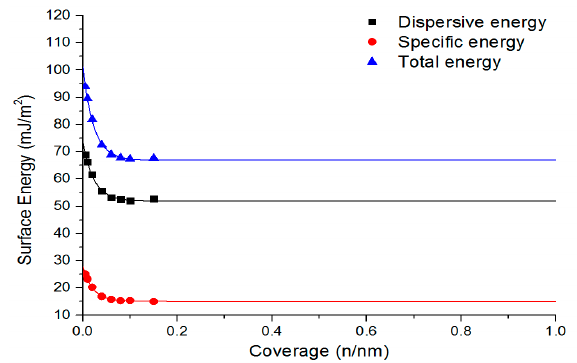
Figure 2. Inverse gas chromatography results (sample 1).